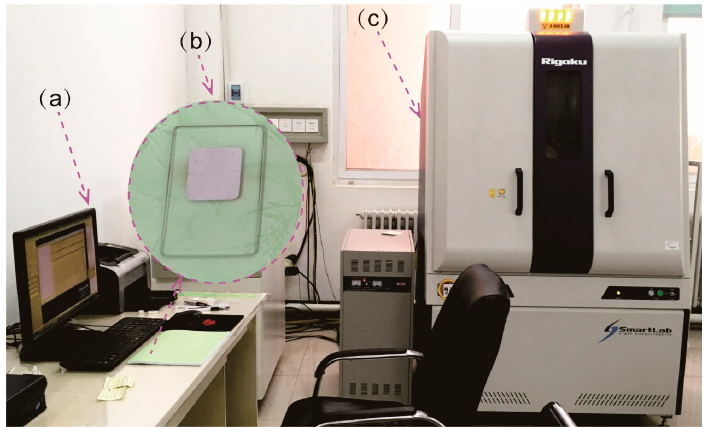
Figure 2. The Empyrean Diffractometer and sample. ( a ) The experiment bench; ( b ) the sample; ( c ) the X-ray diffraction (XRD) analyzer.